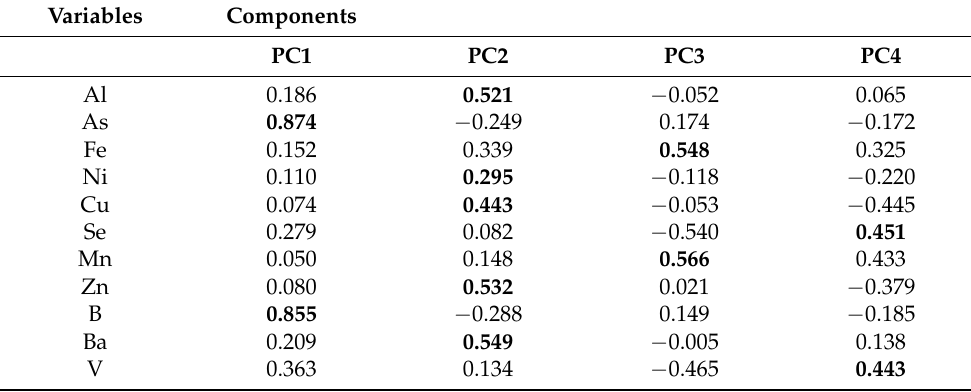
Figure 3. Principal component analysis (3-D space plot) for heavy metal distribution. Table 3. Results of principal component